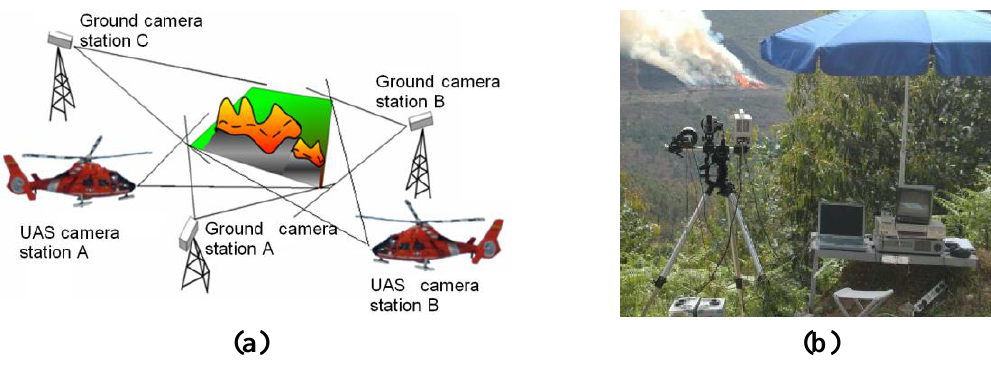
(b) Picture of a ground station with one Mitsubishi IRM-300 infrared camera and